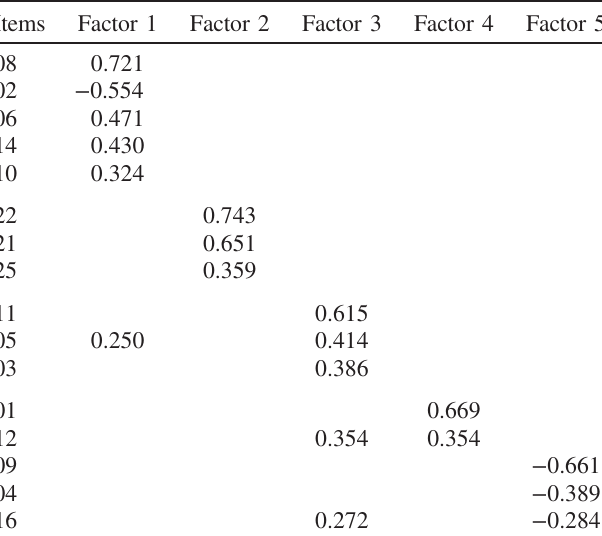
TABLE VI. Initial five-factor loadings for group A. Loadings less than 0.25 have been suppressed. EFA involved approxi- mately half of the section 1 students. These loadings represent results after a filtering of the original 30